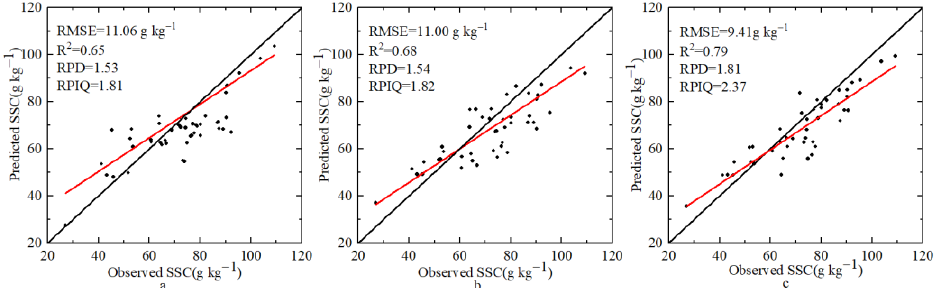
Figure 5. Scatter plot of the three best hybrid models. ( a ) PSOCNN model; ( b ) GA-CNN model; ( c ) SA-CNN model.